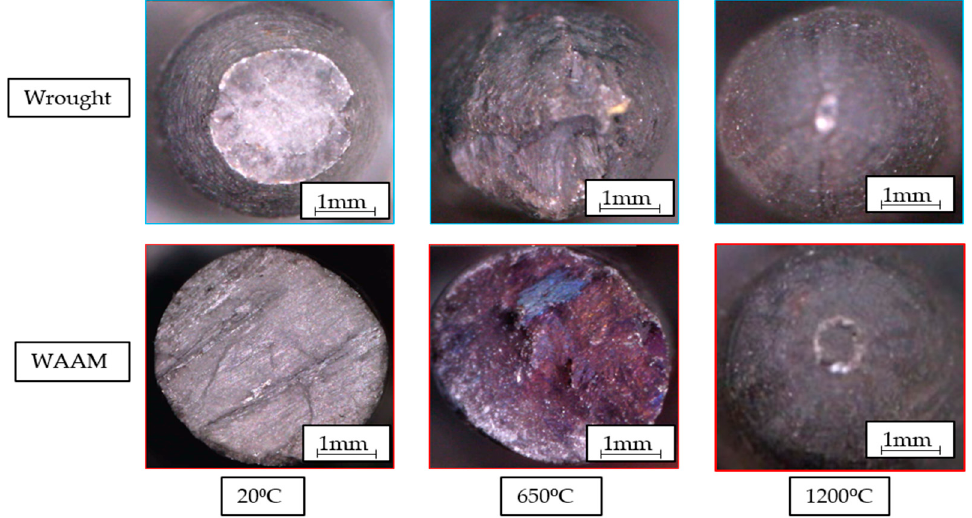
Figure 10. Typical optical microscopic (OM) images of fracture surfaces after the tensile test conducted at various temperature for WAAM and Wrought IN718